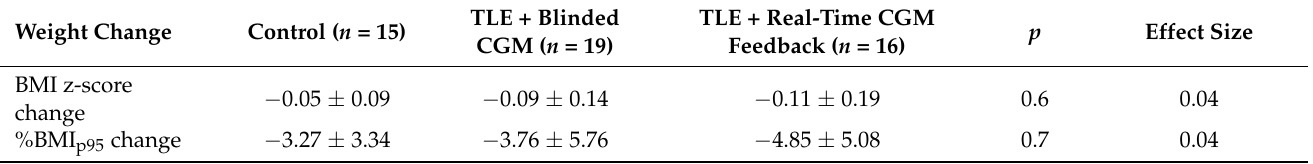
Table 3. Weight change between baseline and week 12 across intervention arms.